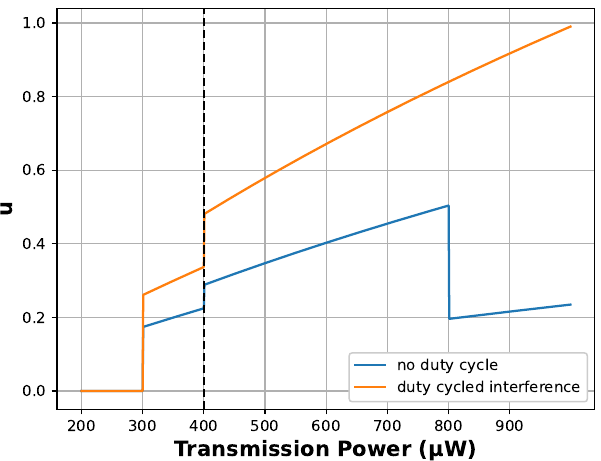
Figure 7. Normalised utility with transmission